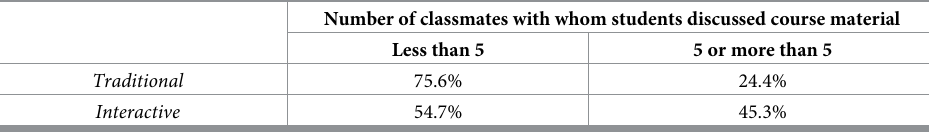
PLOS ONE | https://doi.org/10.1371/journal.pone.0212477 March 7,